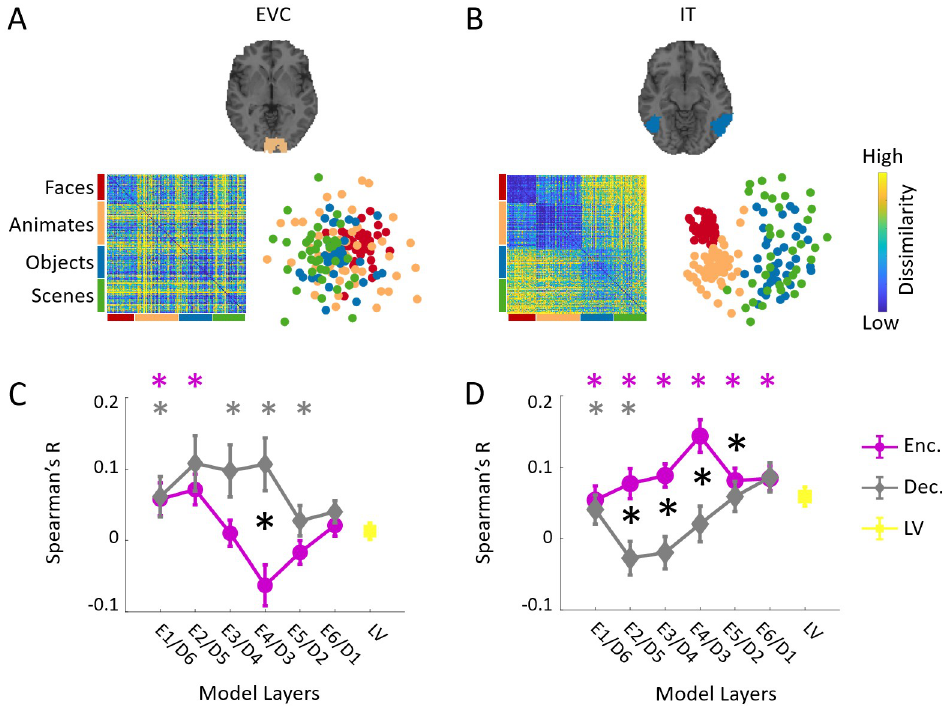
Fig 4. Spatial representational comparisons. (A) Neural representations in early visual cortex (EVC). The subject- averaged EVC RDM matrix, and its 2D multidimensional scaling visualization. (B) Neural representations in inferior temporal area (IT). The subject-averaged IT RDM matrix, and its 2D multidimensional scaling visualization. (C) Encoder, decoder and LV layer RDMs are correlated (Spearman’s R) with subject-specific EVC RDMs. The averaged correlations over subjects with standard error of the mean are depicted. (D) Encoder, decoder and LV layer RDMs are correlated (Spearman’s R) with subject-specific IT RDMs. The averaged correlations over subjects with standard error of the mean are depicted. The color coded ( � ) above each panel in C-D indicates that the correlation of the corresponding layer is significantly above zero. The black ( � ) indicates the correlations of the corresponding encoder and decoder layers are significantly different (N = 15; two-sided ttests; false discovery rate corrected at P <